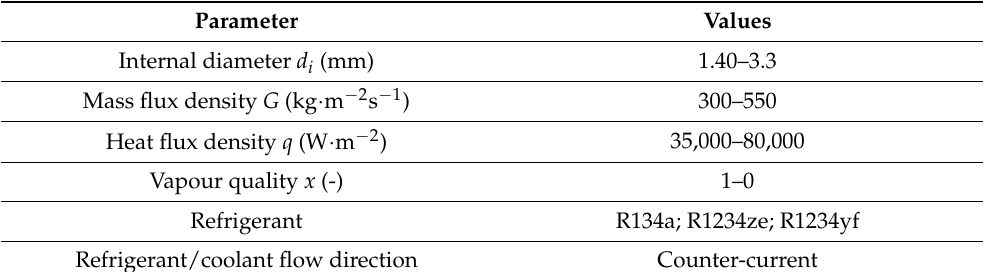
Table 1. The scope of research.